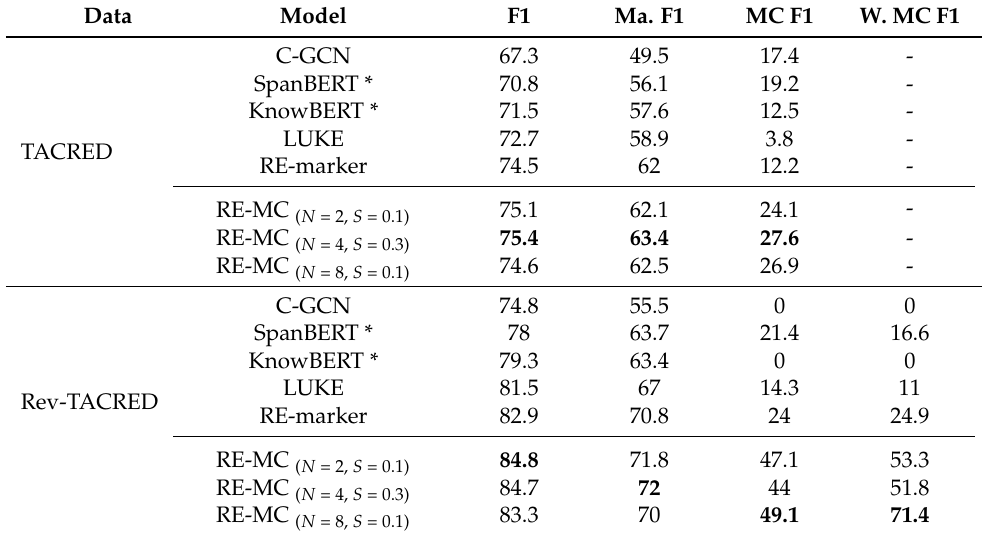
Table 4. The test scores on TACRED and Rev-TACRED. Results with * are from [6].